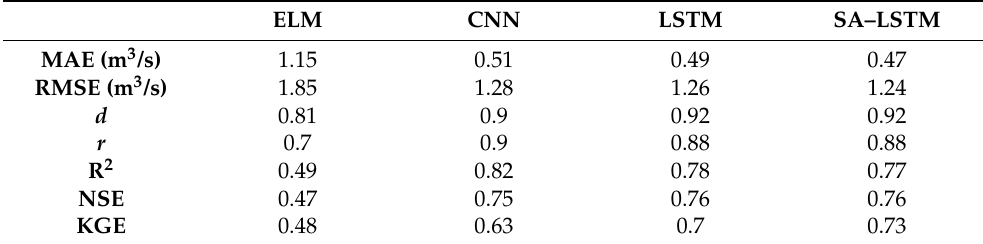
Table 3. Summary of model evaluation metrics during the testing period (the best performing model is highlighted with respect to each metric). ELM CNN LSTM SA–LSTM MAE (m 3 /s) 1.15 0.51